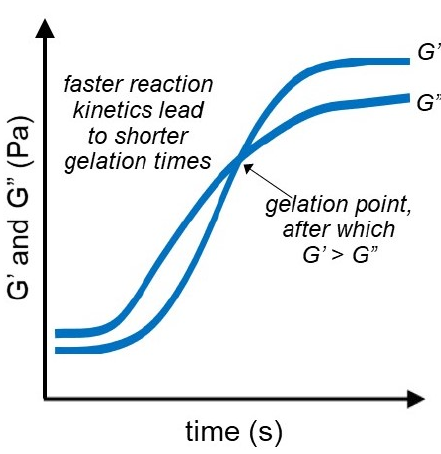
Figure 4. Strain sweep or amplitude sweep in hydrogels shows the linear viscoelastic region (LVR) as well as the threshold strain required above which shear thinning behavior is observed.